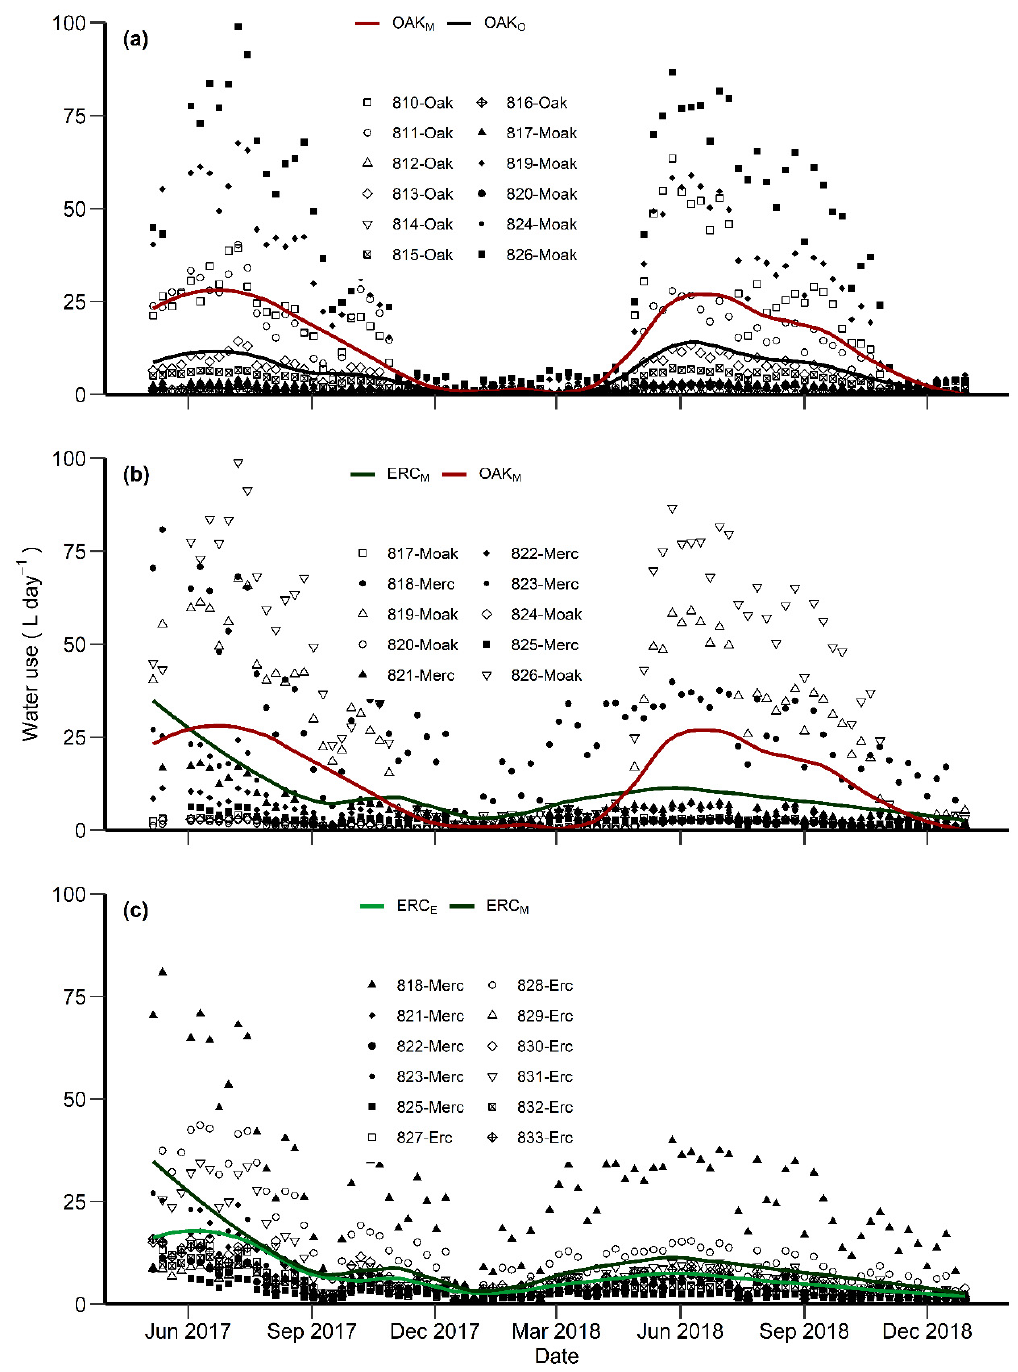
Figure 6. Calibrated daily water use for individual post oaks and redcedars from the OAK stand ( a ), MIX stand ( b ) and ERC stand ( c ). Lines are locally weighted regressions for OAK O , OAK M , ERC M , and ERC E , respectively.